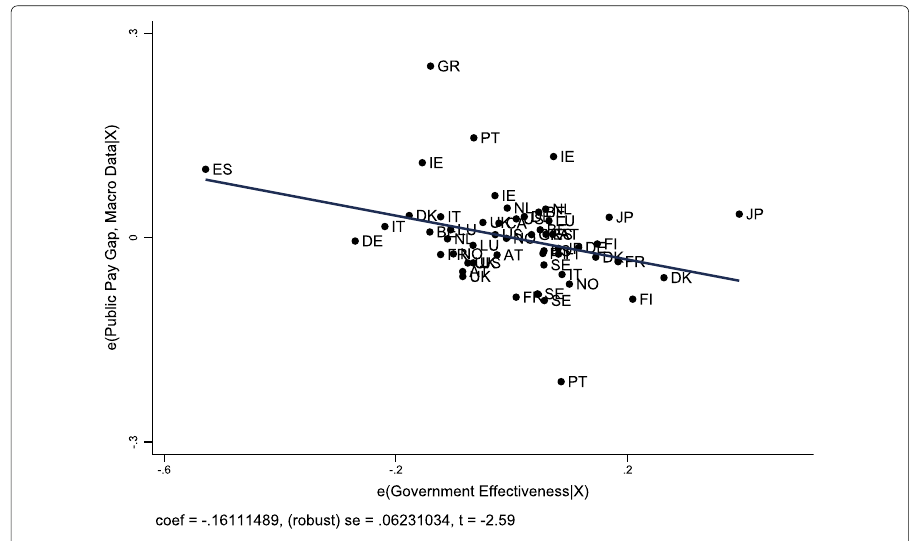
Fig. 4 Partial correlation between government effectiveness and the public pay gap. Notes: This figure shows the correlation between 5-year changes in the quality of public services of a country and changes in the public sector pay gap, once other characteristics are controlled for, namely changes in the number of public employees and changes in openness; see column (4) of Table 5. The negative slope indicates that